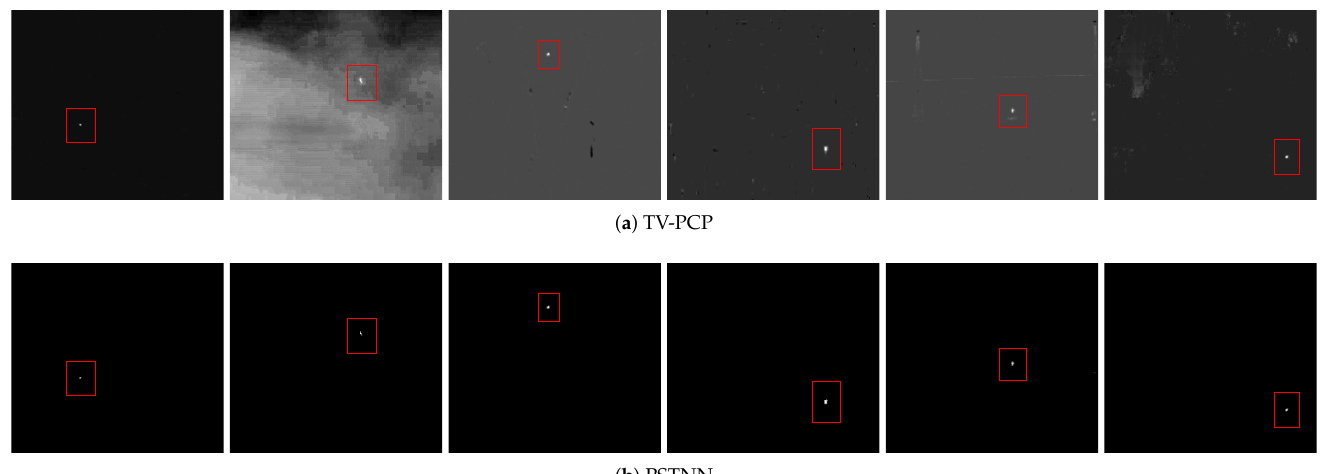
Figure 8. From left to right are the detection results of 1 ∼ 6 sequence images.